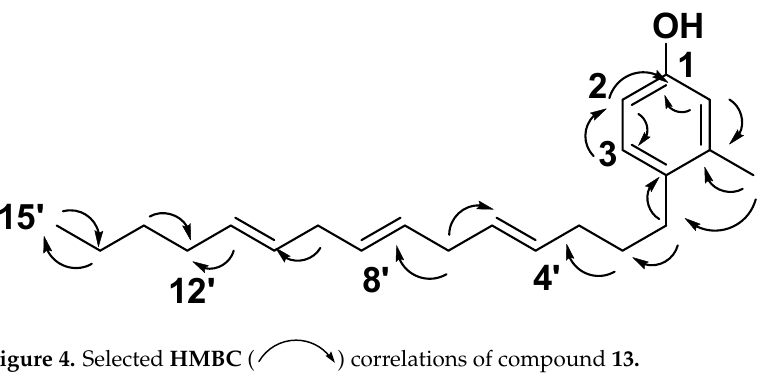
Figure 4. Selected HMBC ( ) correlations of compound 13.